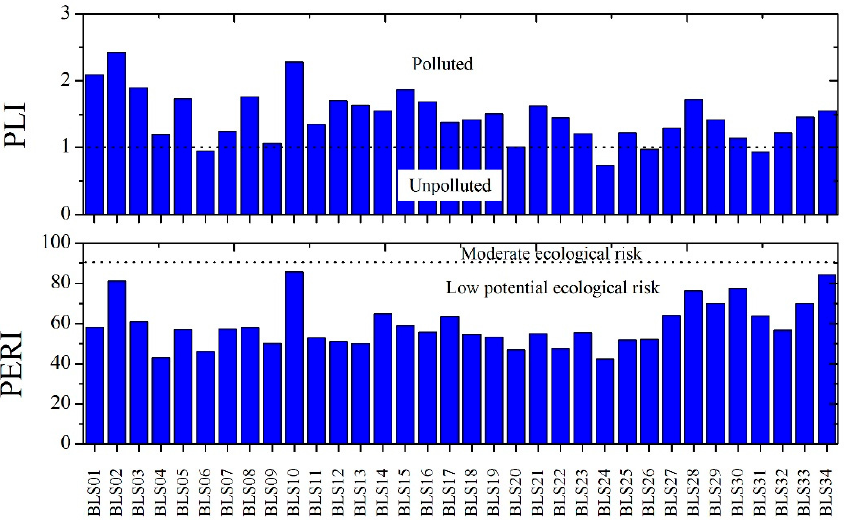
Figure 6. Pollution load index (PLI) and potential ecological risk index (PERI) for surface sediments of Batticaloa lagoon.